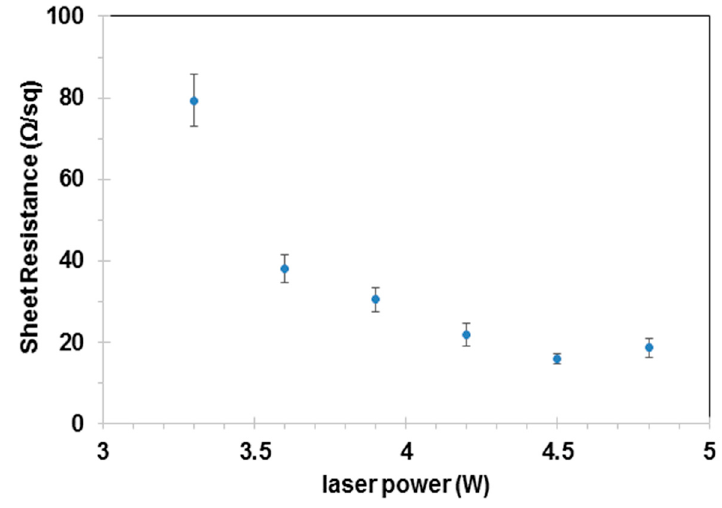
Figure 4. Sheet resistance as a function of laser power.